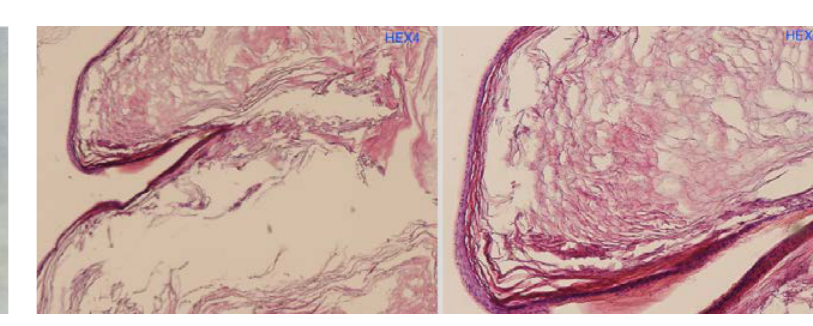
Figure 3. Samples of the lesion after opera- tion.